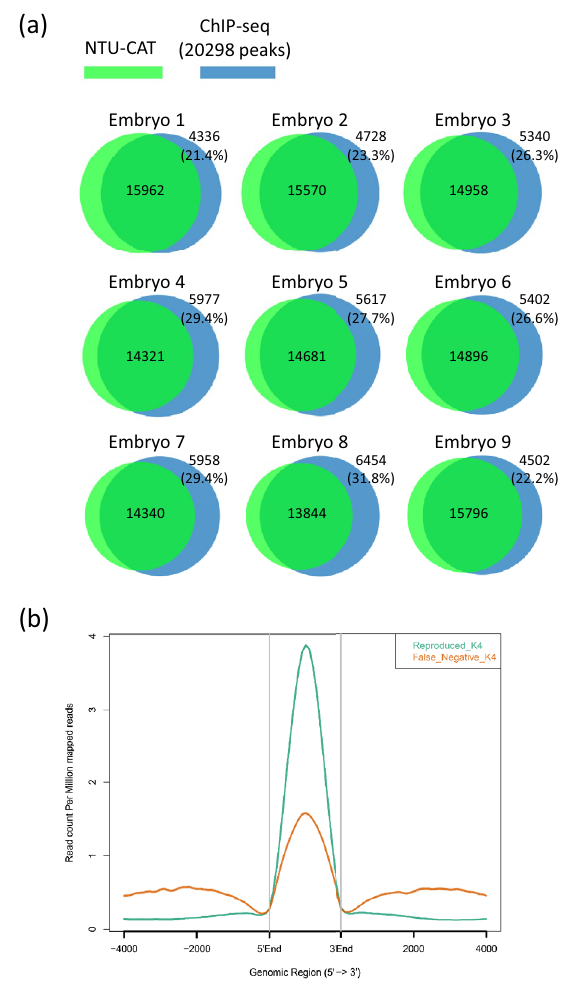
Figure 5. Validation of false negative peaks in NTU-CAT for H3K4me3. ( a ) Calculation of the false negative rate (FNR) in NTU-CAT as the number of H3K4me3 ChIP-seq peaks (the overlapping peaks of Blastocysts 1 and 3 in our previous report 11 ), which did not overlap with the respective NTU-CAT peaks divided by the total number of ChIP-seq peaks. ( b ) Average profile plot of the H3K4me3 signals in reproducible and missing (false negative in NTU-CAT) peaks in ChIP-seq compared with NTU-CAT. The overlapping peaks of Blastocysts 1 and 3 in our previous report 11 were compared with the NTU-CAT Rep1 sample shown in Fig. 2. The figure was generated by ngs.plot 28 using the Blastocysts 1